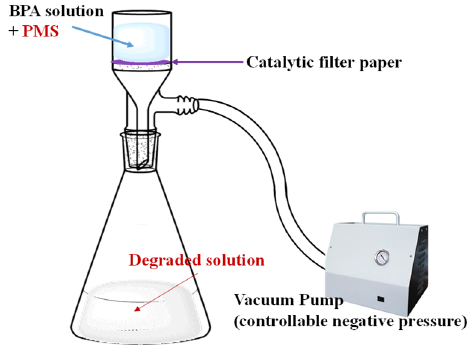
Figure 1. Schematic illustration of the BPA degradation by ZFP.